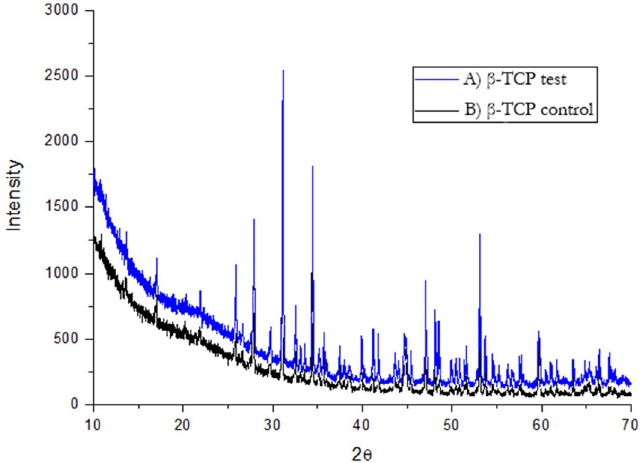
Figure 4. X-ray diffraction patterns (PERKIN-ELMER PHI ESCA 5500 SYSTEM). β-TCP test and β-TCP control samples. The dominant crystalline phases in both materials generate the same intense sharp peaks characteristics of β-TCP (black triangles).